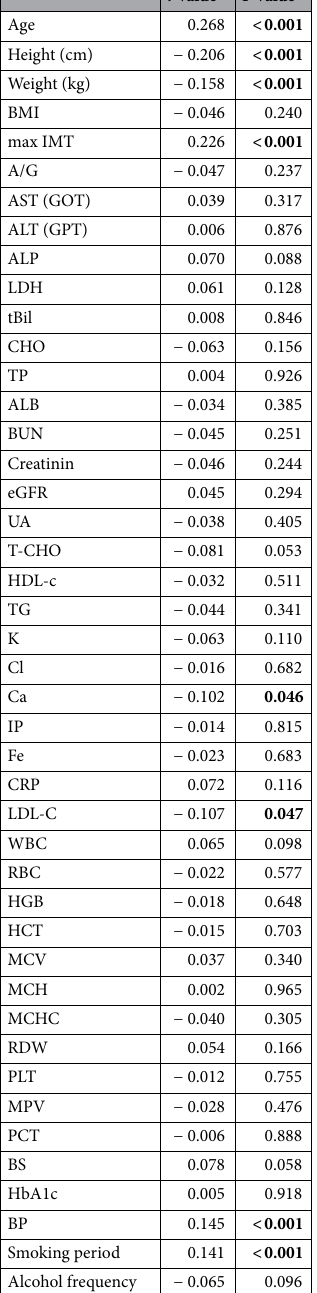
Table 7. Correlation analysis of the s-AP3D1-Ab levels with data on participants in the Sawara Hospital cohort. Correlation coefficients ( r values) and P values obtained using Spearman’s correlation analysis are shown. Significant correlations ( P < 0.05) are marked in bold font. max IMT, maximum intima-media thickness; A/G, albumin/globulin ratio; AST, aspartate aminotransferase; ALT, alanine aminotransferase; ALP, alkaline phosphatase; LDH, lactate dehydrogenase; tBil, total bilirubin; CHO, cholinesterase; TP, total protein; ALB, albumin; BUN, blood urea nitrogen; creatinine, eGFR, estimated glomerular filtrating ratio; UA, uric acid; T-CHO, total cholesterol; HDL-C, high-density lipoprotein cholesterol; TG, triglyceride; K, potassium; Cl, chlorine; Ca, calcium; IP, inorganic phosphate; Fe, iron; CRP, C-reactive protein; LDL-C, low-density lipoprotein cholesterol; WBC, white blood cell; RBC, red blood cell; HGB, hemoglobin; HCT, hematocrit; MCV, mean corpuscular volume; MCH, mean corpuscular hemoglobin; MCHC, mean corpuscular hemoglobin concentration; RDW, red cell distribution width; PLT, platelet; MPV, mean platelet volume; PCT, procalcitonin; BS, blood sugar; HbA1c, glycated hemoglobin; BP, blood